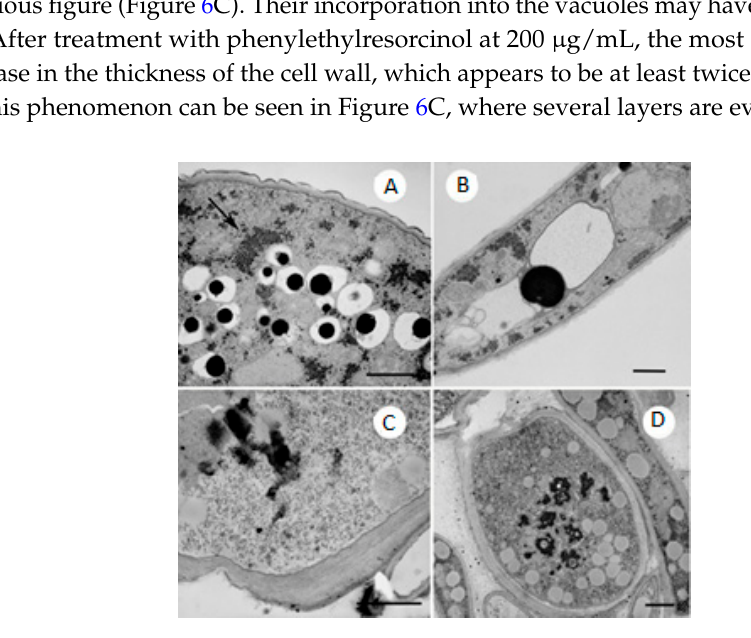
Figure 6. ( A ) M. gypseum treated with 100 μ g/mL phenylethylresorcinol. Numerous small vacuoles containing non-electron-transparent material. Note the accumulation of glycogen near the vacuoles.